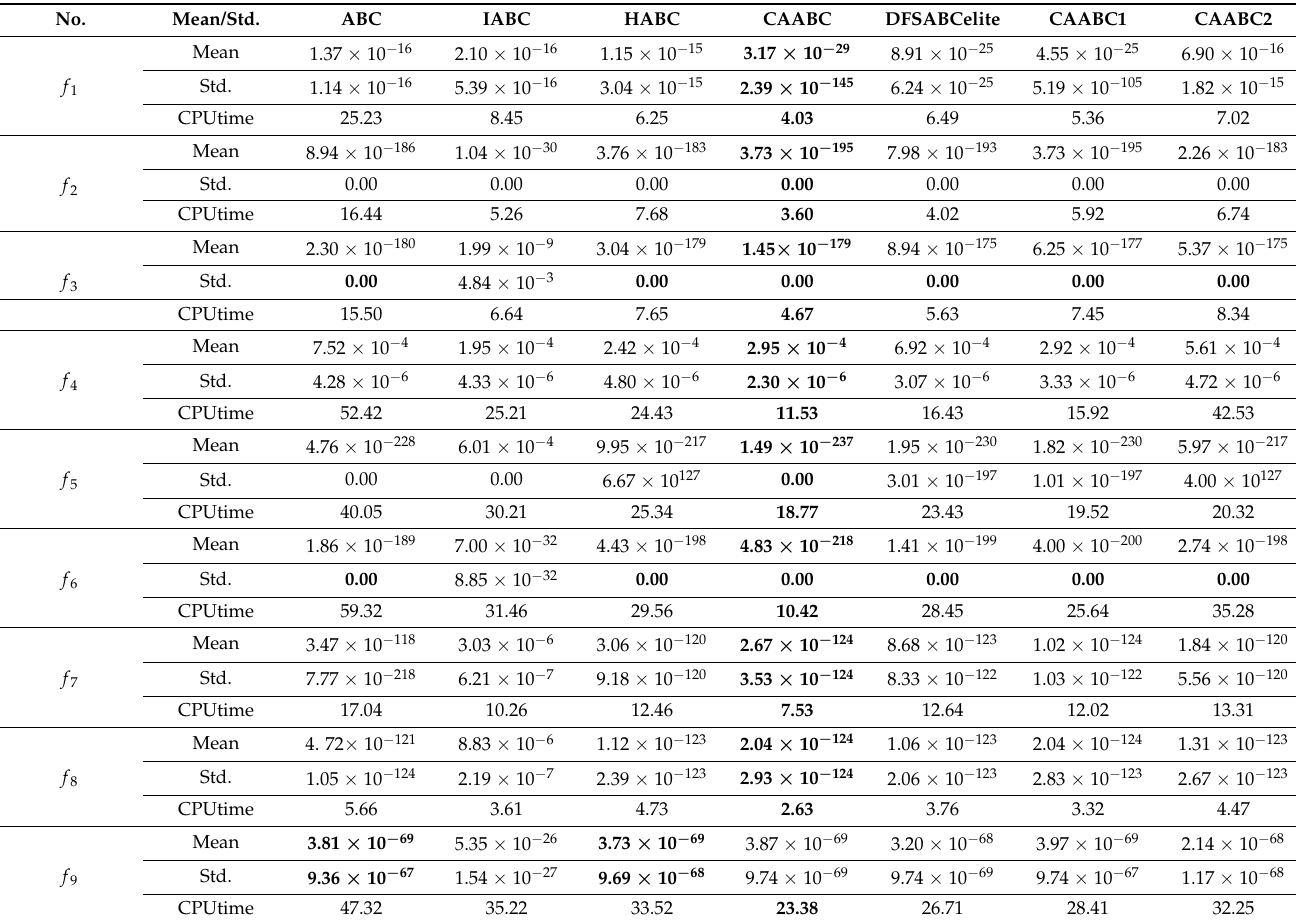
Table 3. Comparison with other improved Artificial Bee Colony in 30